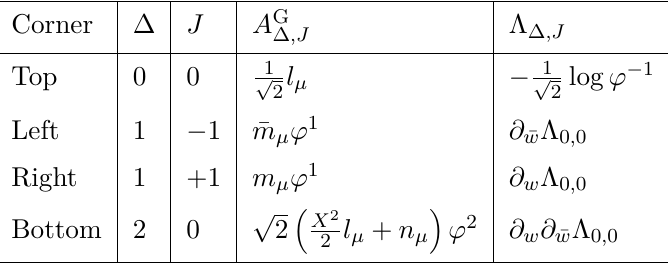
Table 12. Elements of the celestial diamond corresponding to large U(1) gauge symmetry.